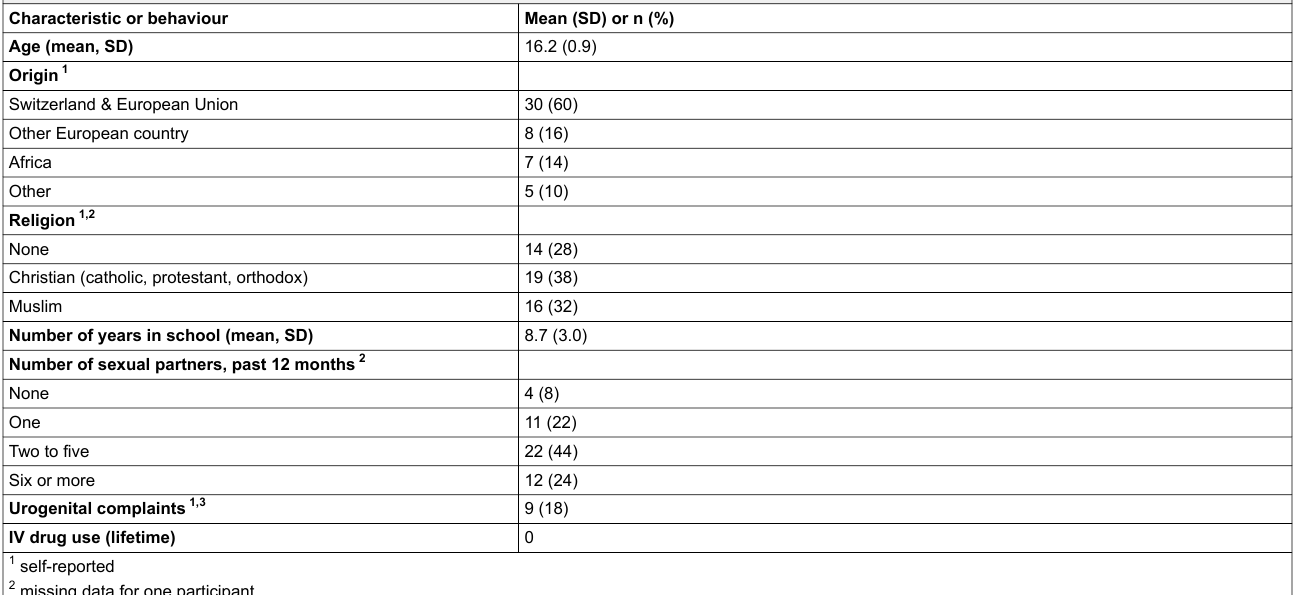
Table 1: Sociodemographic and health characteristics of 50 male detainees participating in the study. Characteristic or behaviour Mean (SD) or n (%) Age (mean, SD) 16.2